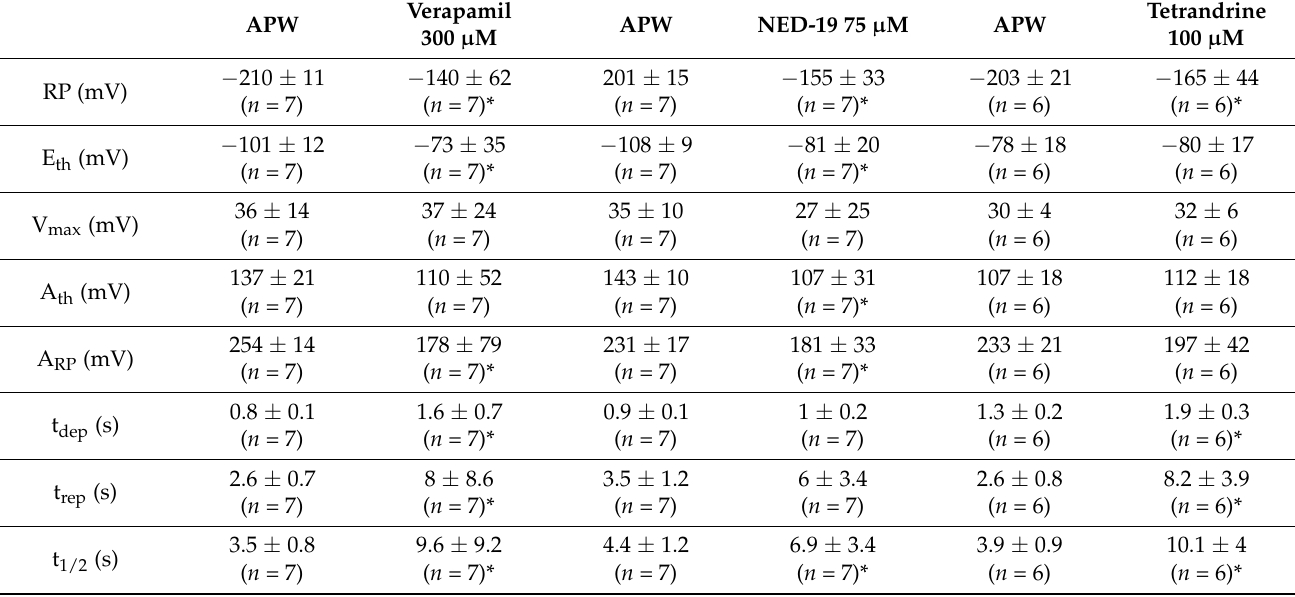
Table 1. Average values of resting potential ( RP ) and parameters describing the electrically evoked action potentials in the same internodal Nitellopsis obtusa cells in the control solution APW and after treatment with 300 µ M verapamil, 100 µ M tetrandrine, and 75 µ M NED-19. Asterisks indicate a statistically significant difference ( p < 0.05). Verapamil APW APW NED-19 75 µ M 300 µ M